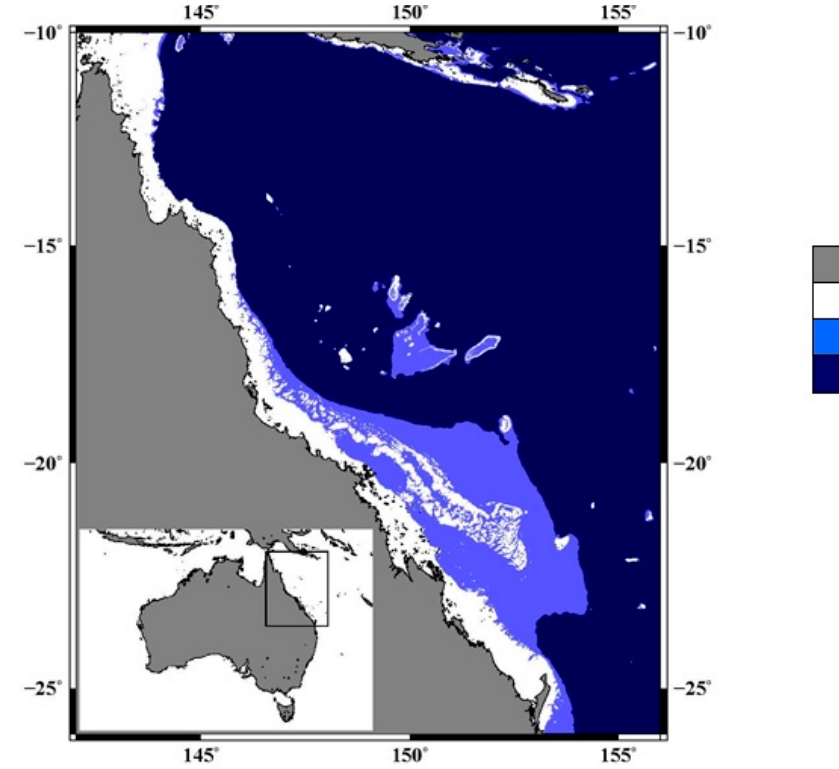
Figure 1. The bathymetry of GBR based on the GBR100 model. It covers the deep ocean (dark blue), shelf (steel blue) and coastal (white) zones.